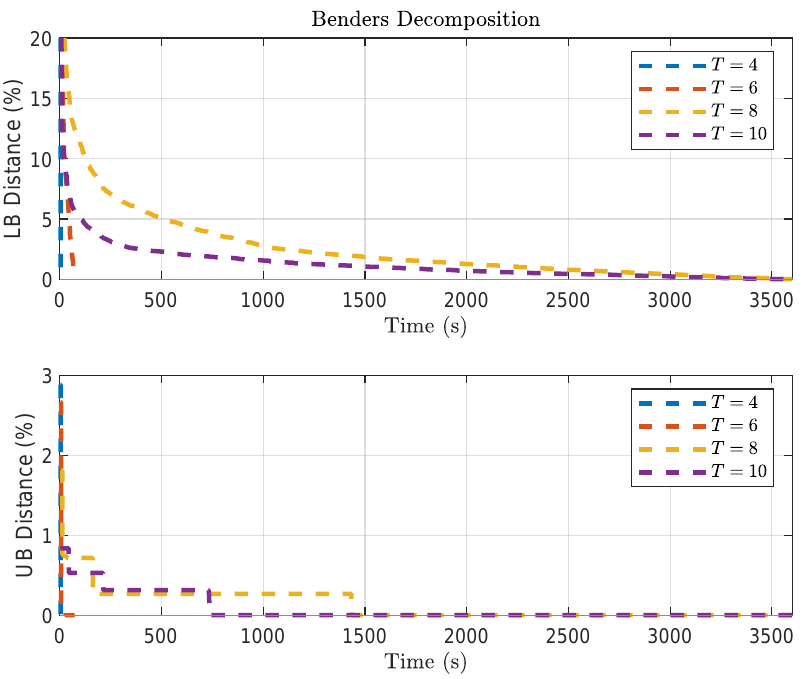
Figure 4. Trajectory of the bounds in Benders Decomposition solution, for problem M = 8, considering a varying length of T for the prediction horizon.